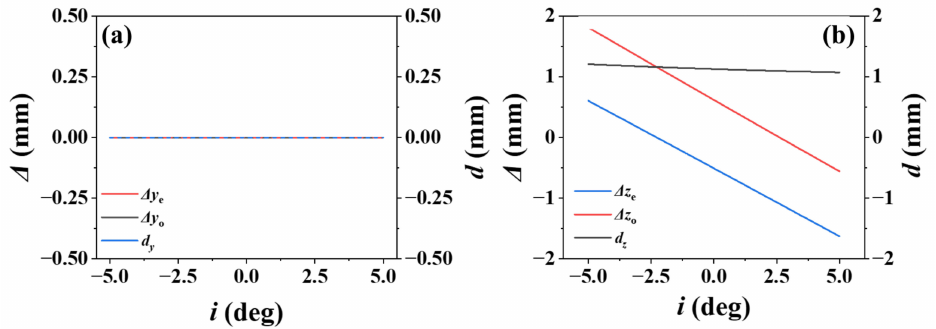
Figure 5. Offset and displacement as function of i when ω = 0 ◦ : ( a ) Along y direction; ( b ) Along z direction.